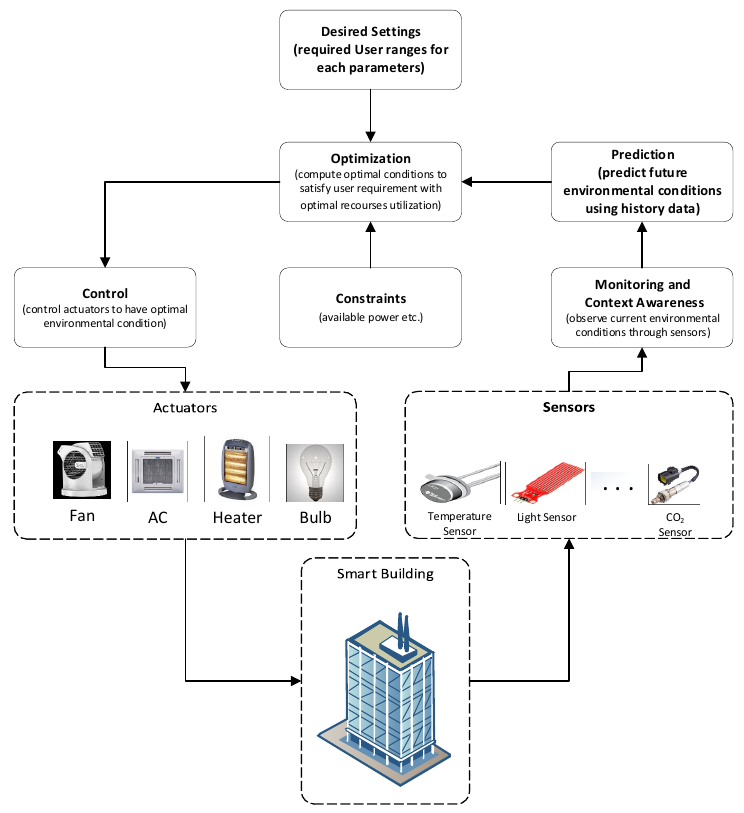
Figure 2. Smart energy management system: conceptual